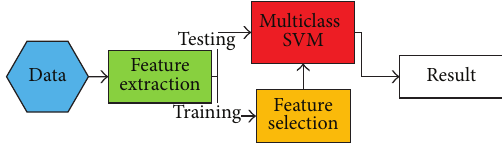
Figure 1: Block diagram of the proposed